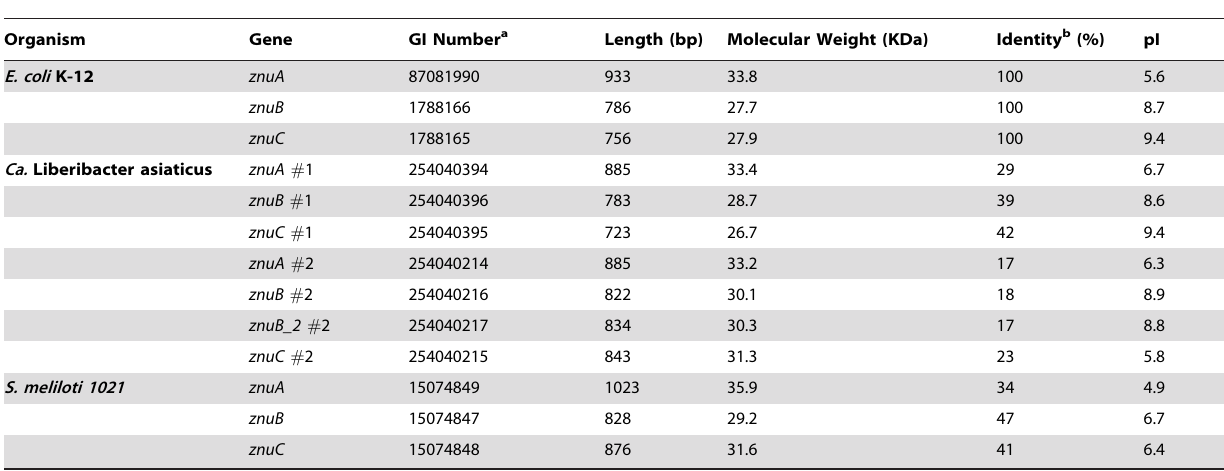
Table 2. Bioinformatic analysis of the components comprising the Znu gene clusters.